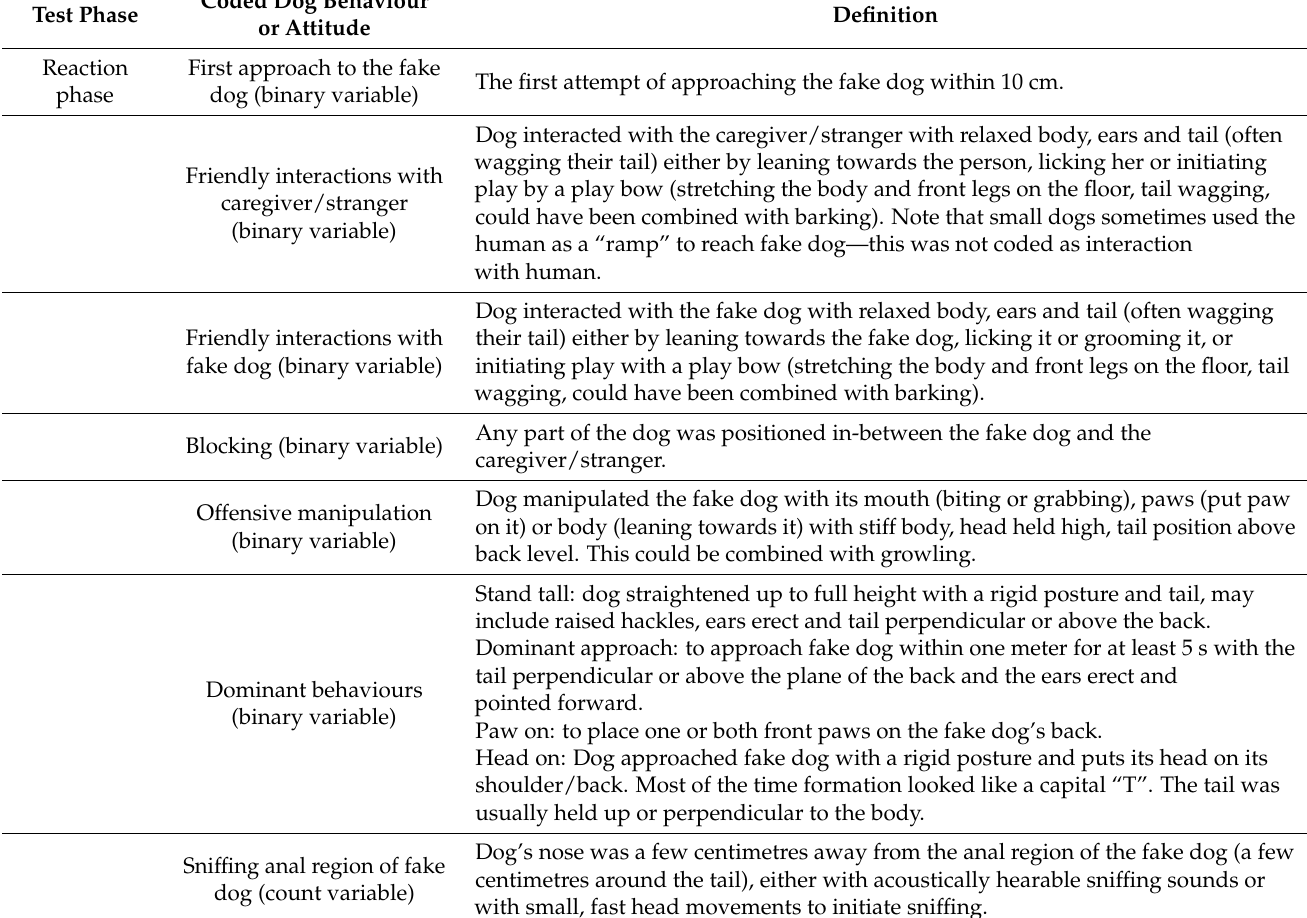
Table 2. Coded dog behaviours in the respective test